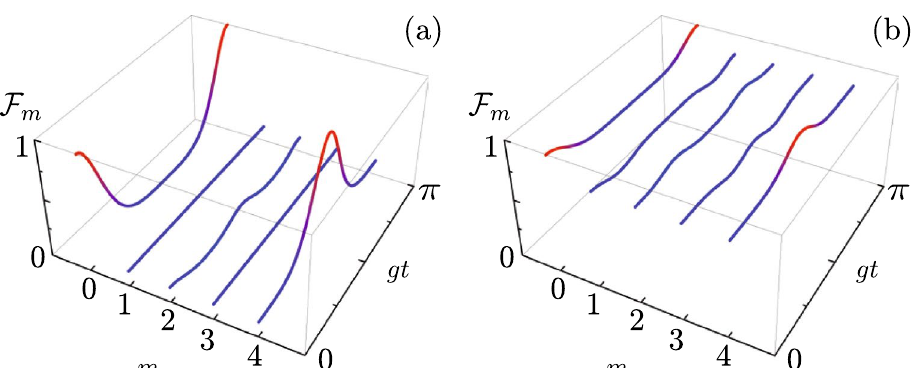
2 , for an initial ( a ) single photon = √ 0.2 . As expected for a = π/ 2 and =